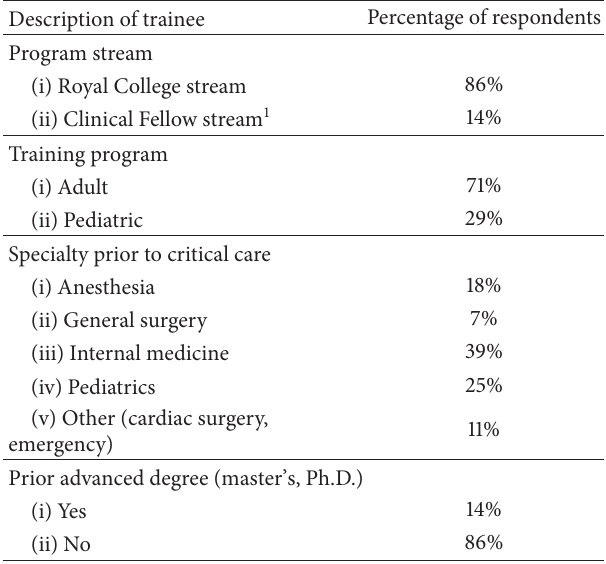
Table 2: Demographics of critical care trainees who responded to the survey.